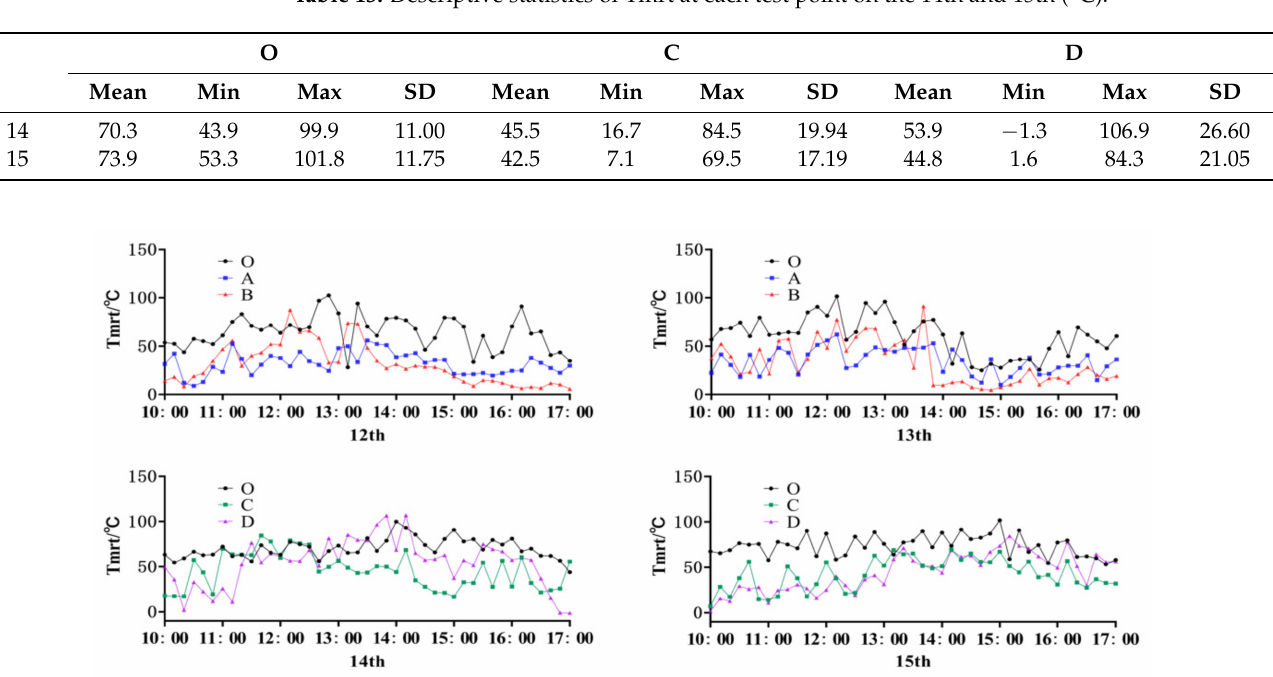
Table 13. Descriptive statistics of Tmrt at each test point on the 14th and 15th ( ◦ C).